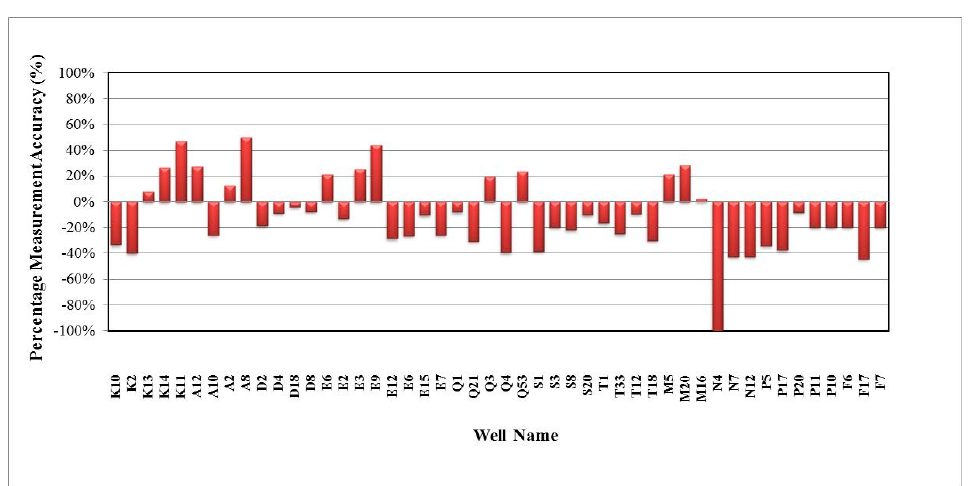
Figure 18. Water rate measurement accuracy using the Blasius correlation. Energies 2018 , 11 , x FOR PEER REVIEW